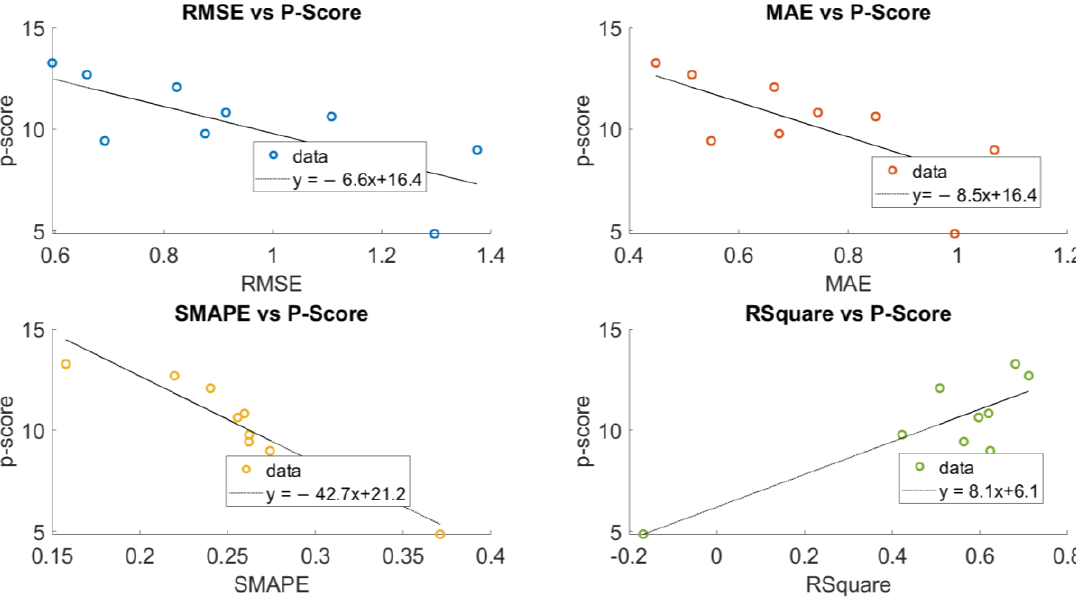
Figure 4. Scatter Plot between the Accuracy Metrics and the p-score Values.